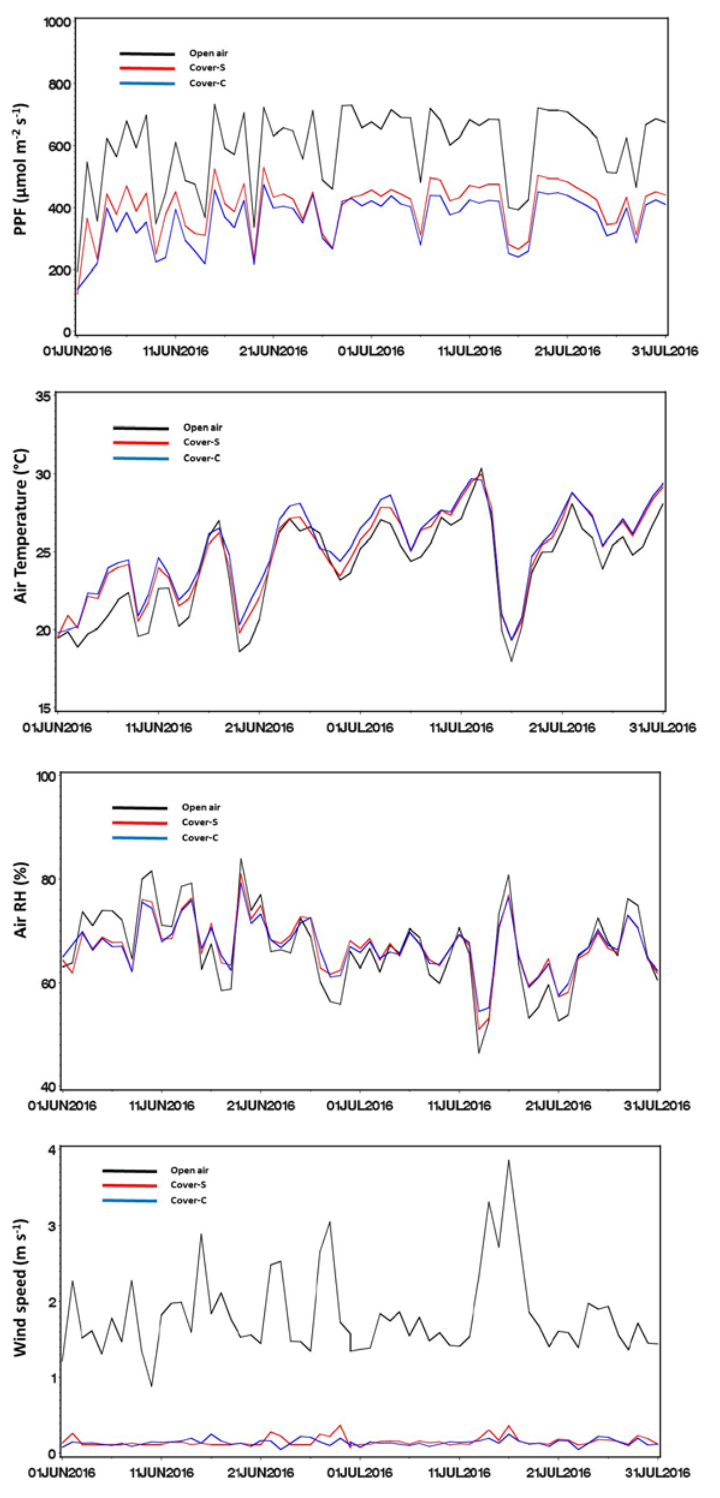
Figure 6. Course of average daily photosynthetic photon flux (PPF), air temperature, air relative humidity and wind speed recorded in June and July of the second year of trial, in open field and under plastic covers C (Coverlys ® agrotextile) and S (Serrosol film).